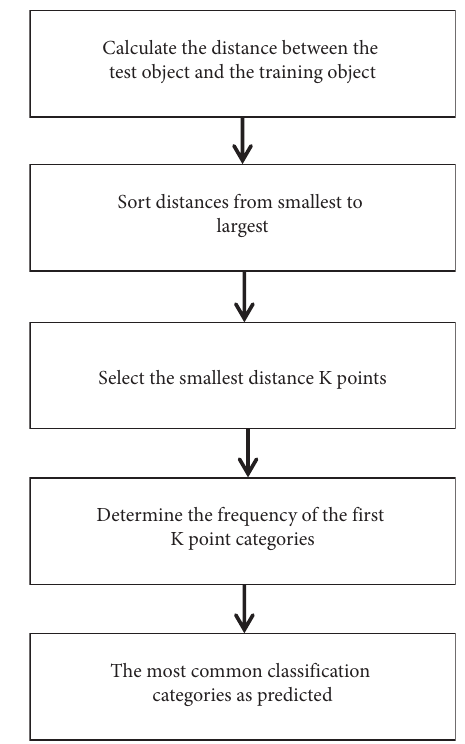
Figure 11: K-nearest neighbor (KNN) classification process. Table 4: Confusion